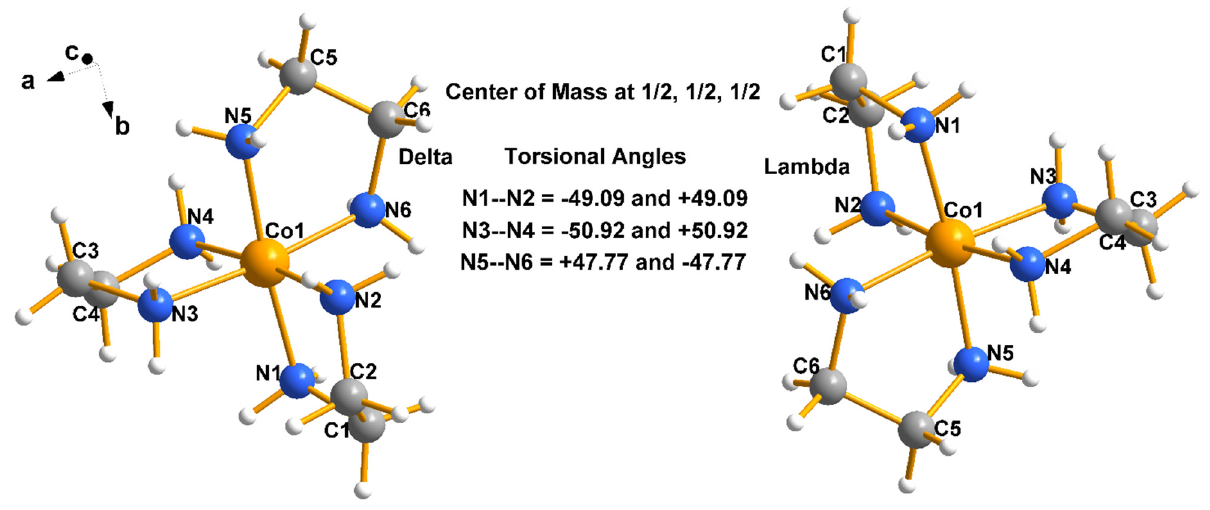
Figure 1. In the crystalline form of (±)-[Co(en) 3 ]OxBr. 3H 2 O, the Co cations are either Lambda (meaning that the sequential sense of rotation about the metal describes an anticlockwise motion (right in the figure)), or a clockwise motion, Delta (left in the figure). The species is a racemate crystallizing in space group C2/c. The torsional angles show that the absolute configurations are exactly opposite in magnitude and sign. Such is not the case in the so-called racemate of the tri-iodide monohydrate, described below.